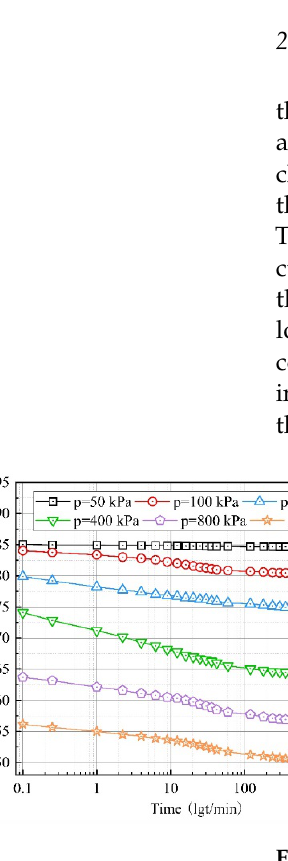
Figure 4. Creep equipment and loading scheme: ( a ) Consolidation instrument; ( b ) Loading-time curve.